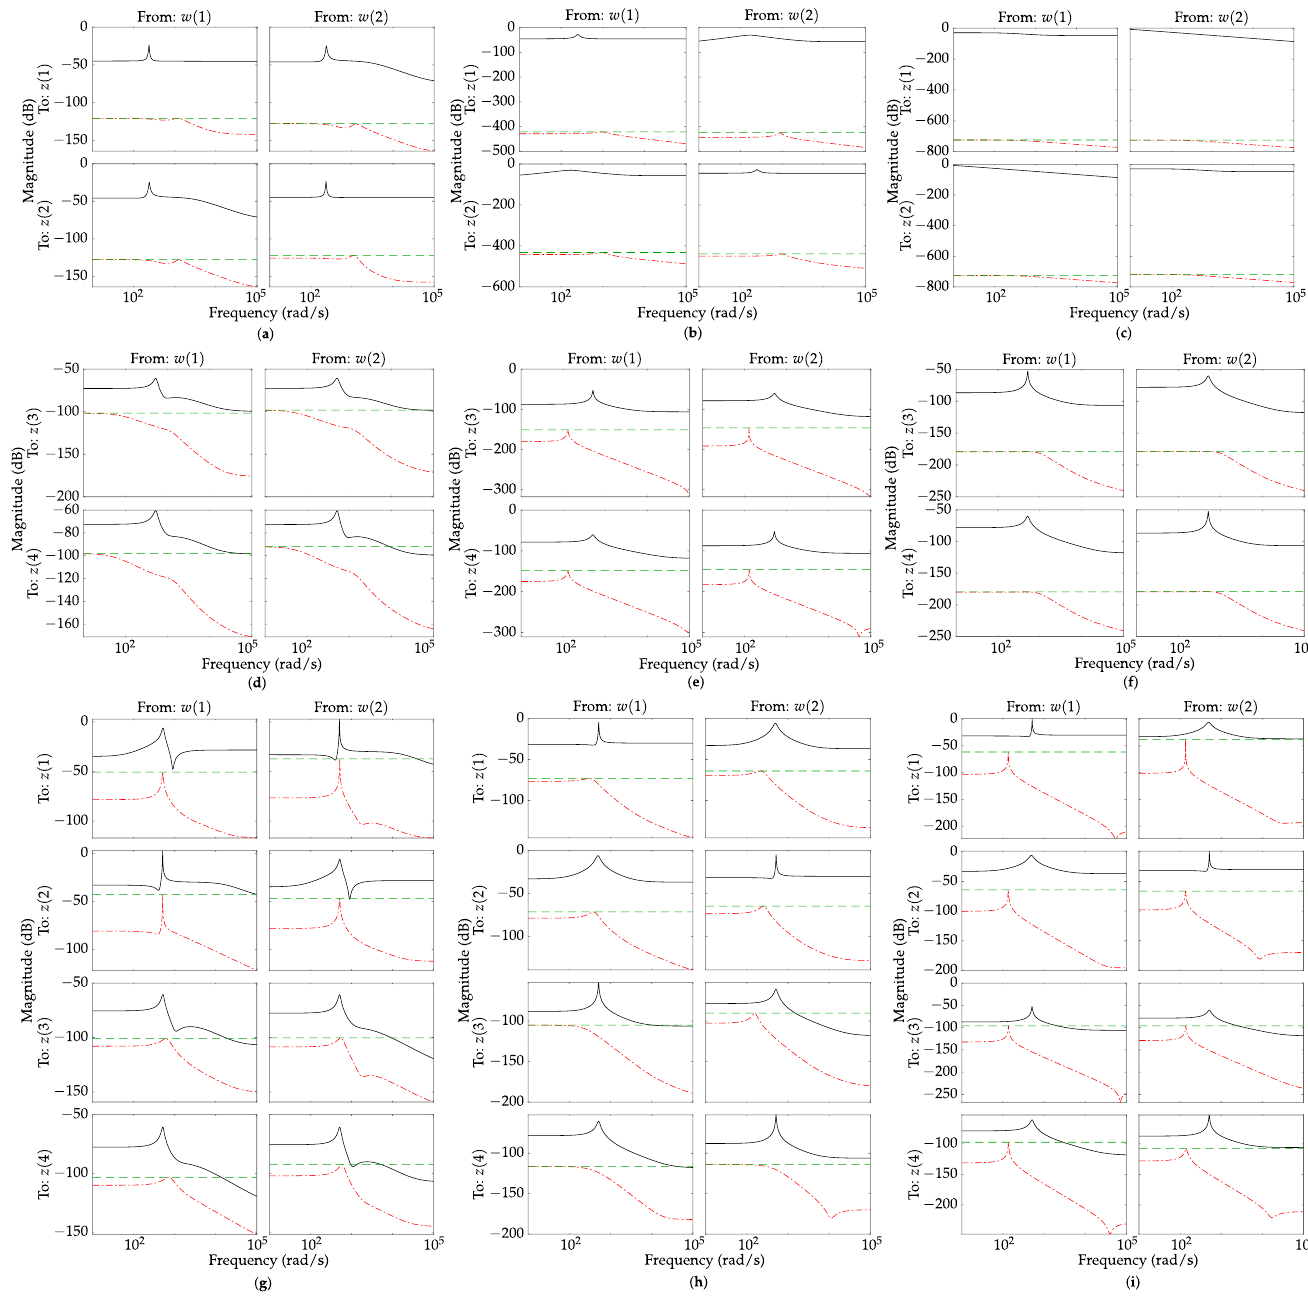
Figure 10. Frequency response of the with initially calculated weights W j ,1 (solid black line), refined weights W j ,1 e (dash-dot red line) and static weights W j ,1 s (dashed green line). ( a ) Case #1 , system 3. ( b ) Case #1 , system 11. ( c ) Case #1 , system 19. ( d ) Case #2, system 3. ( e ) Case #2 , system 7. ( f ) Case #2 , system 13. ( g ) Case #3 , system 3. ( h ) Case #3 , system 5. ( i ) Case #3 , system